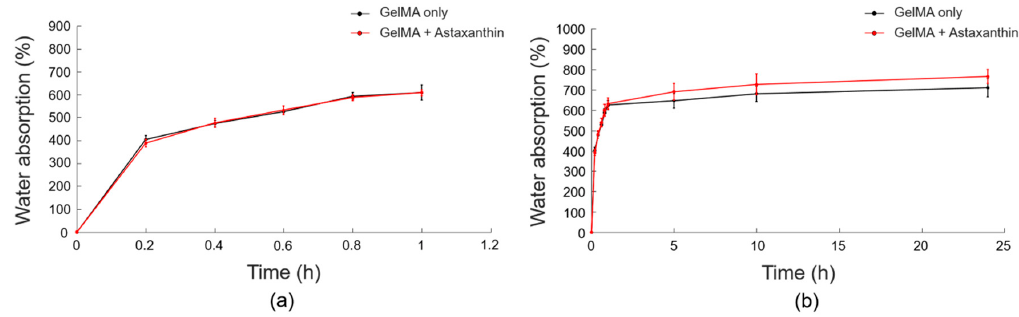
Figure 6. The swelling behaviors of GelMA with astaxanthin (red) and without astaxanthin (black) ( a ) from 0 to 1 hour and ( b ) from 0 to 24 hours. Data are presented as the mean ± standard deviation (n = 4).